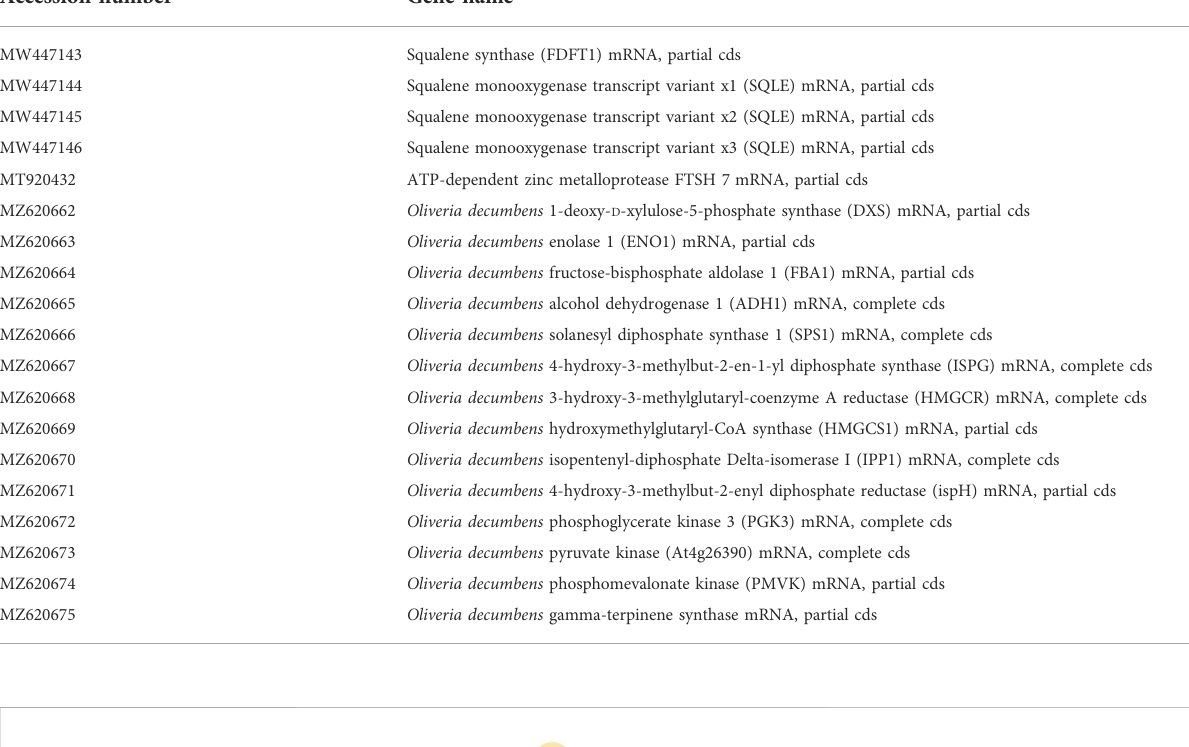
TABLE 8 ( Continued ) List of sequences identi fi ed in Oliveria decumbens in this research so far and deposited to the NCBI database. Accession number